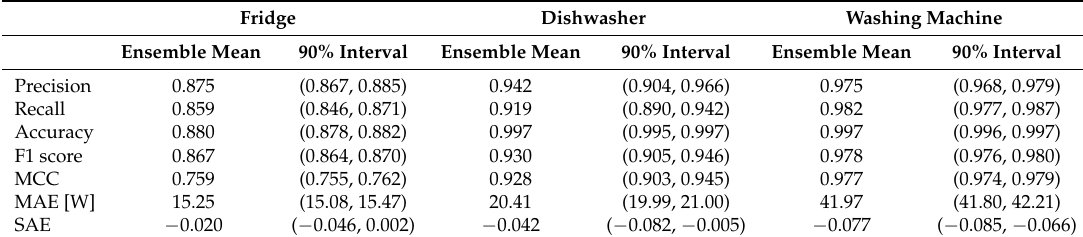
Table 4. Performance of the method for the seen case for house 1 of the UK-DALE dataset. 20 different instances of the neural network have been trained and the value of the ensemble estimate and the 90% range of performance variation are